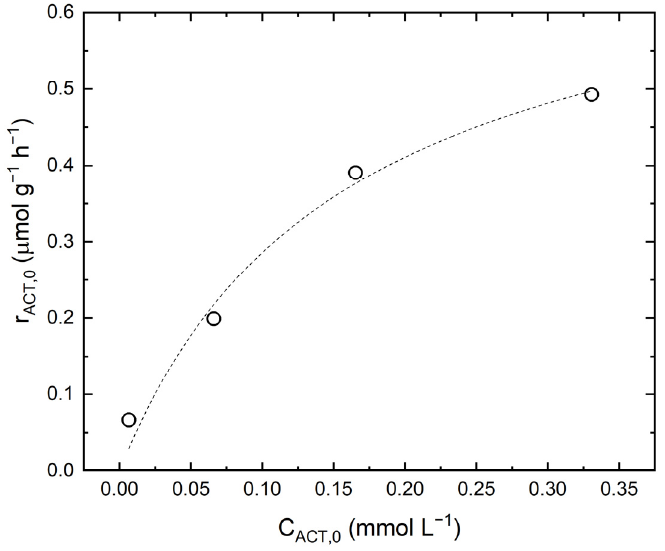
Figure 8. Initial degradation rate of ACT as a function of its inlet concentration. The dashed line represents a Langmuirian fit ( R 2 = 0.982).